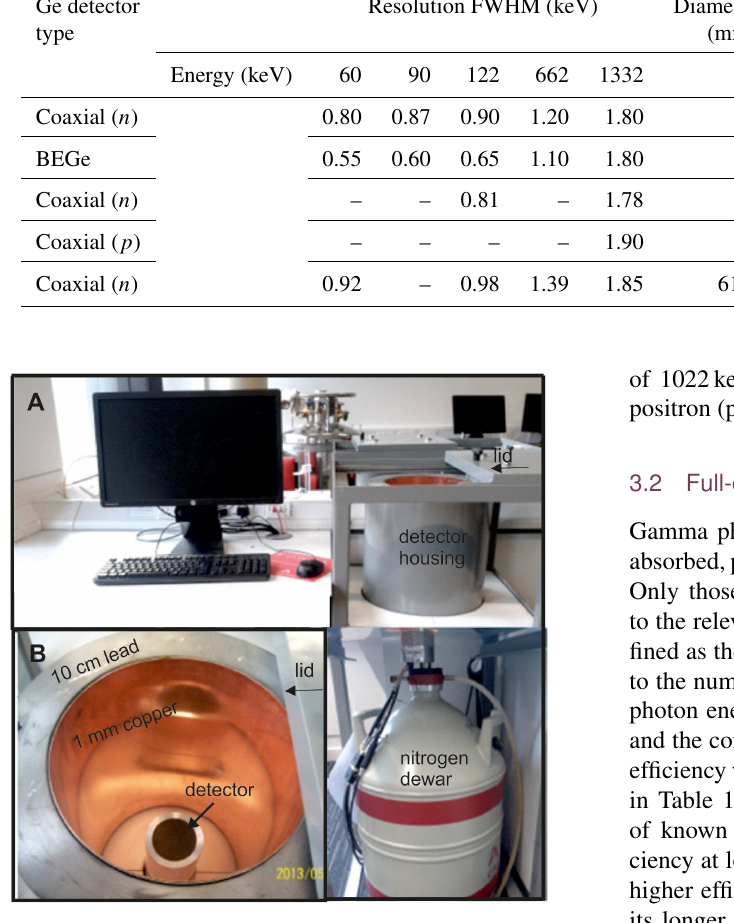
Figure 2. Typical configuration of a gamma spectrometer with (a) detector housing, nitrogen dewar, and PC. (b) View in the de- tector housing; the shield is composed of 10cm low-activity lead, 1mm tin (not visible), and 1mm copper. Amplifier and preamplifier not shown (adopted from Abdualhadi,